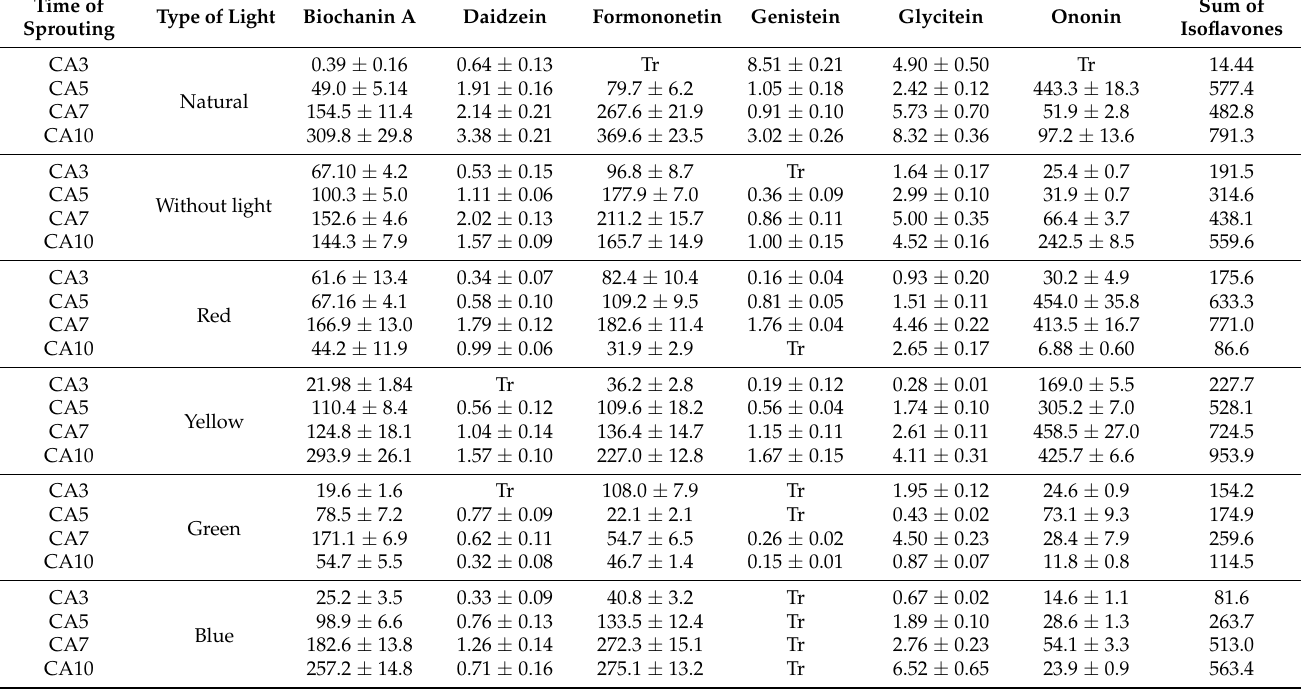
Table 1. Content (mg/100 g dw) of individual isoflavones and their sums in chickpea sprouts (CA) harvested in different LED light conditions for 3, 5, 7, and 10 days (mean ± SD; n = 3).